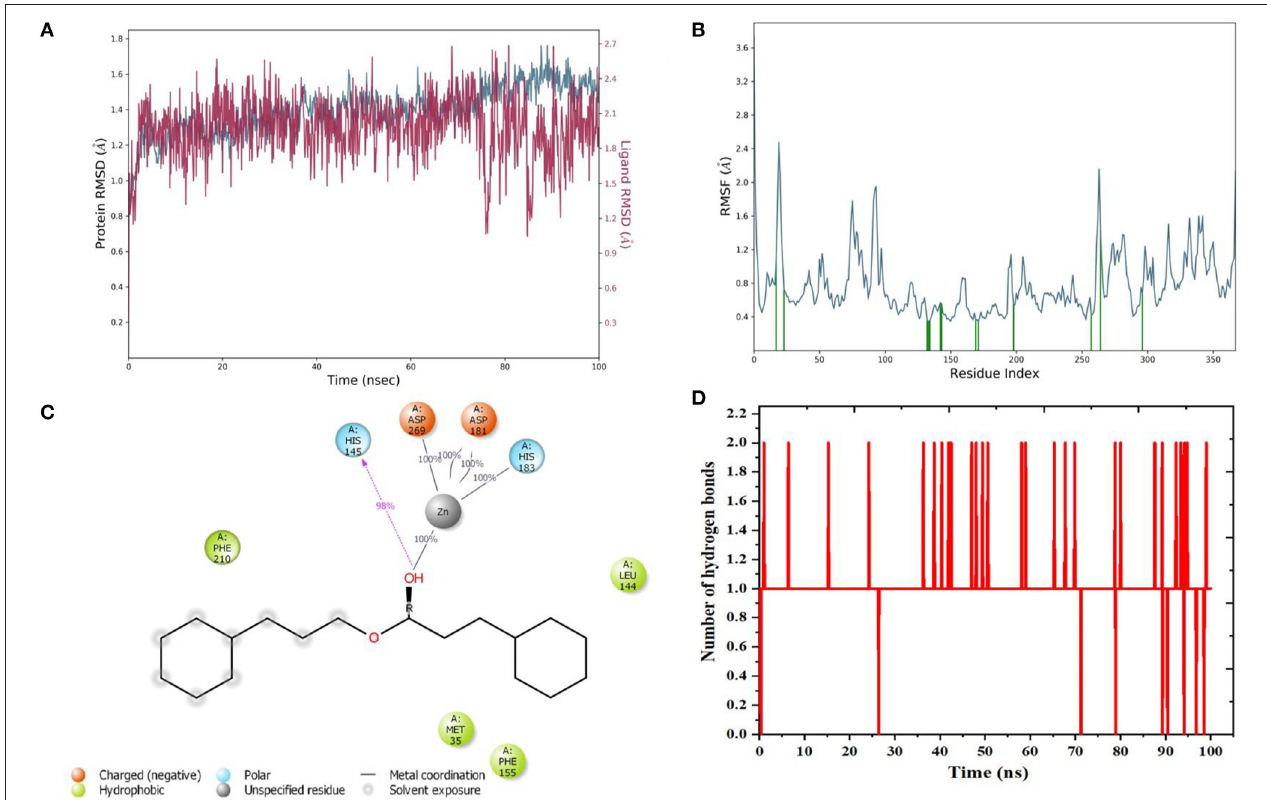
FIGURE 3 | MD simulation analysis of cinnamyl dihydrocinnamate (CMNPD5348) in complex with HDAC 2 during 100 ns MD simulation time (A) Plot of root mean square deviations (RMSD) (protein RMSD (C- α atom of HDAC 2 protein) is shown in gray while RMSD of cinnamyl dihydrocinnamate are shown in red) (B) plot of root mean square fluctuations (RMSF) values (C) plot of ligand interaction in the binding cavity and (D) plot of the number of hydrogen bonding interactions.